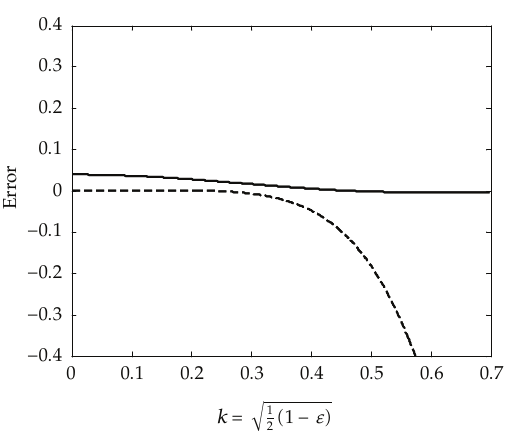
Figure 9: Relative error of the period, MacMillan (cid:4)(cid:4) 4.1 (cid:5) dashed line (cid:5) , asymptotic solution (cid:4)(cid:4) 3.32 (cid:5) solid line (cid:5)